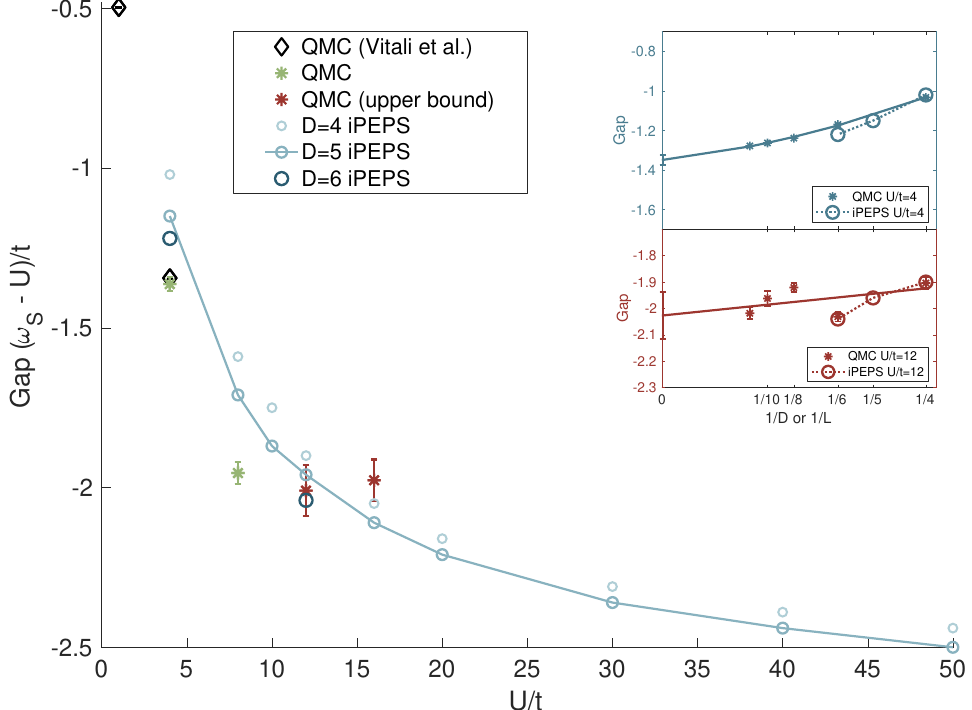
Figure 2: Comparison of iPEPS results for the gap at various values of U / t with our extrapolated QMC results and those of Vitali et al. [ 58 ] . On the y axis, ω the lowest eigenvalue at the S = ( π/ 2, π/ 2 ) point, and we applied a shift of − U / t to better visualize the energy differences over the large range of U / t on the x axis. For the green QMC points the data is well converged, while the results shown in red are an upper bound of the true gap due to an exponential scaling of the computational cost (see Appendix A for more details). Inset: Comparison of finite bond-dimension iPEPS and finite size QMC data for the gap at U / t = 4 (blue data) and U / t = 12 (red